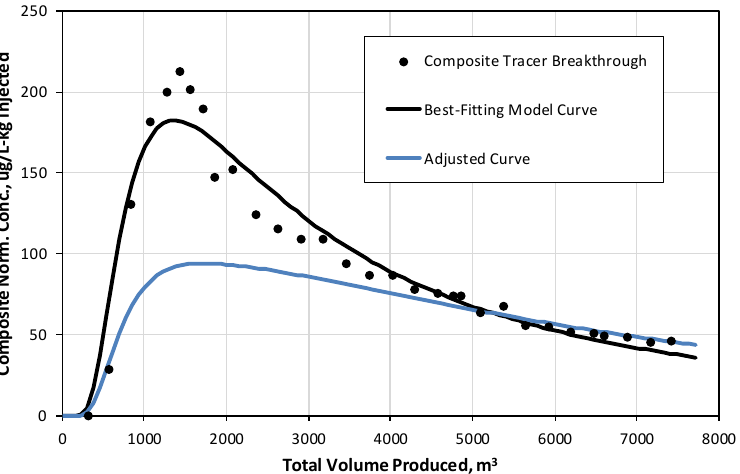
Figure A18. Best RELAP model fit to the composite tracer breakthrough curve in the fall 2017 test and adjusted model fit to account for nonconservative transport behavior of cations and anions (as observed in HH 15-16 dithionite push-pull tests).